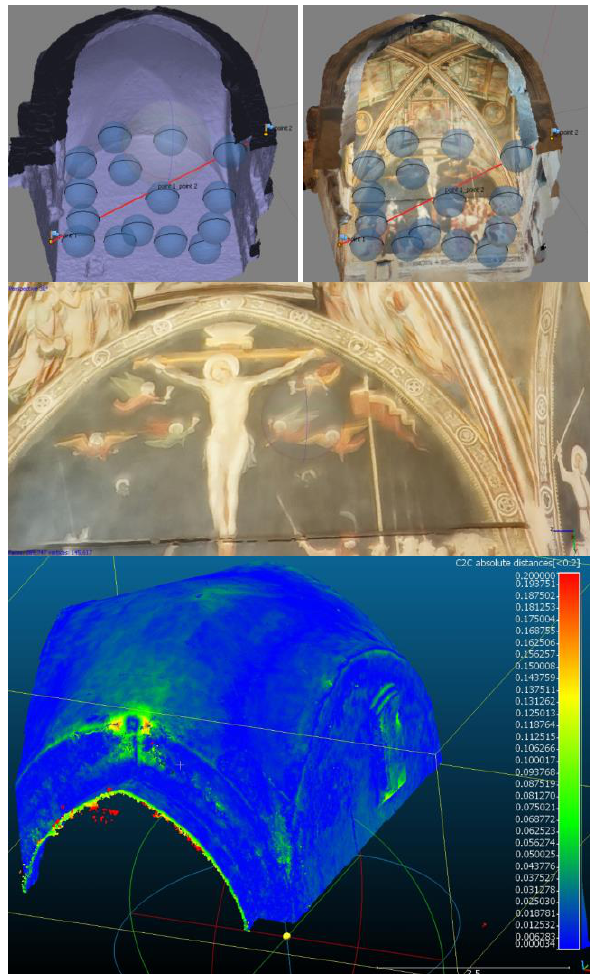
Figure 8. Results with the equirectangular projection generated with the workflow “c” (Fig. 2). The overall accuracy estimated with CloudComapare is 10 mm.